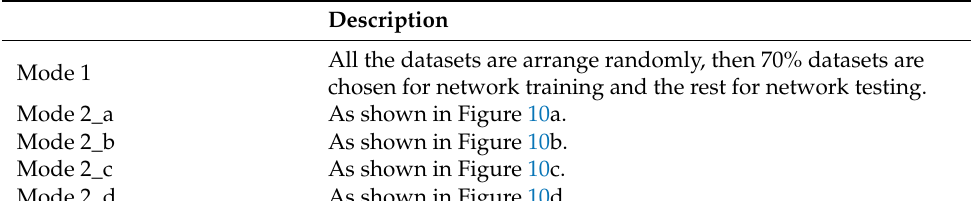
Table 3. Description of the training and testing datasets arrangement.